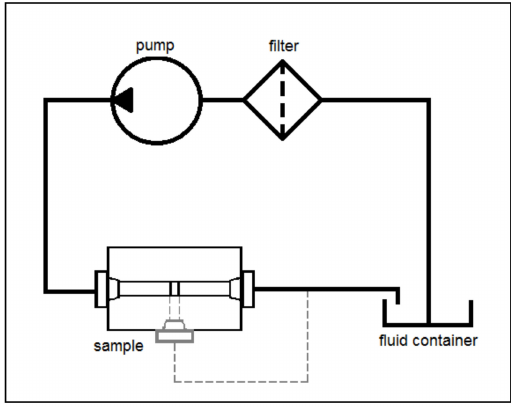
Figure 3. Schematic sketch of the measurement